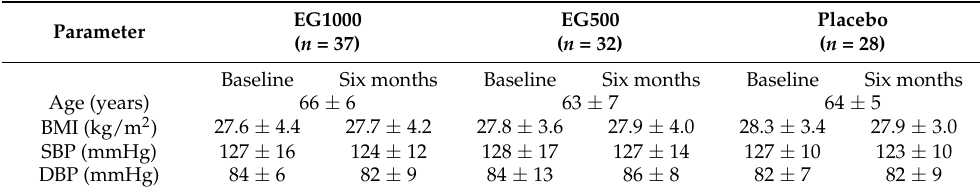
Table 1. Clinical parameters (BMI and blood pressure) at baseline and after six months in the study groups.